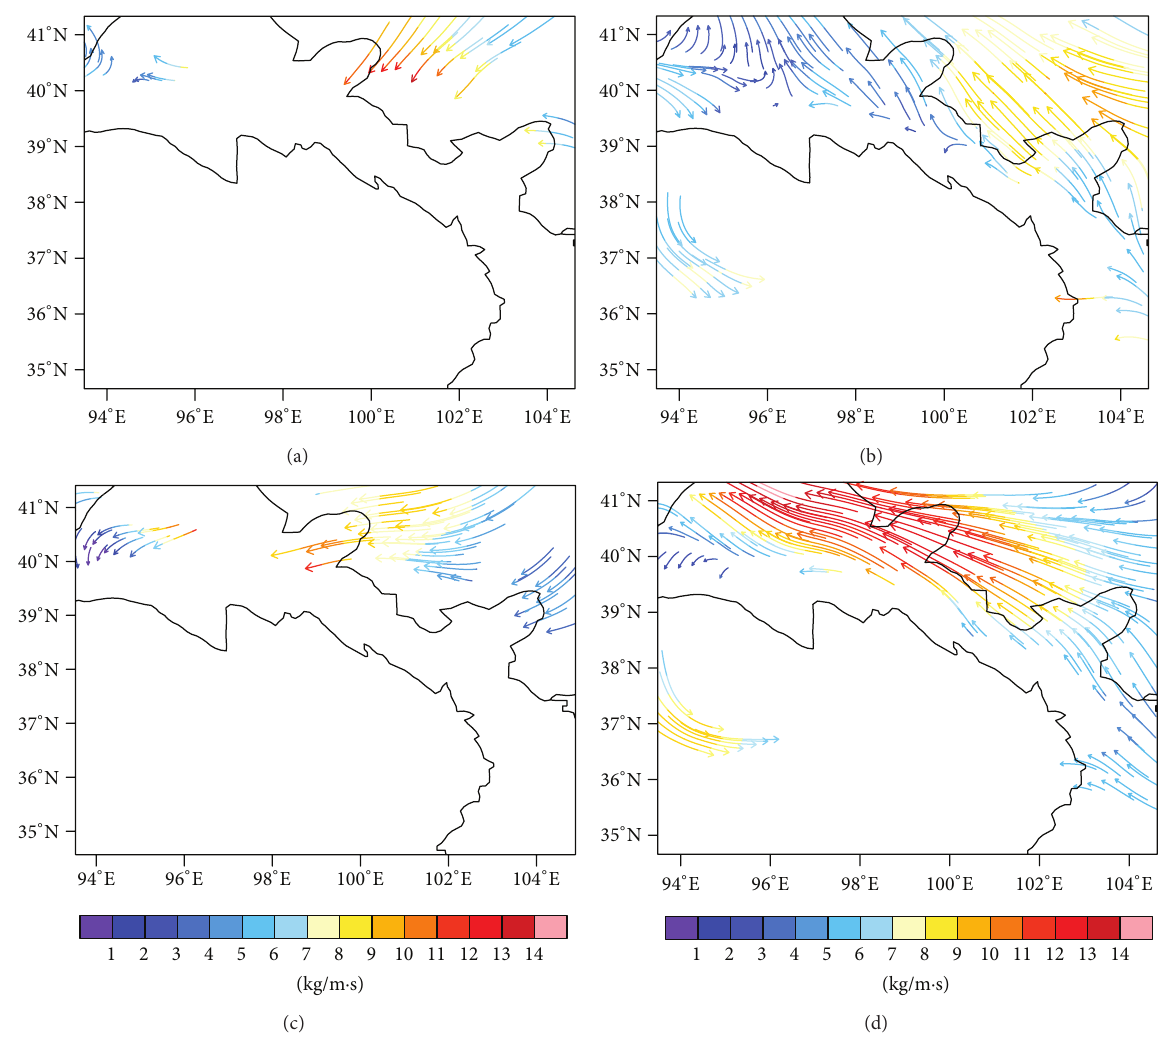
Figure 12: Moisture flux initial field for the CTRL and DA experiments: (a) CTRL; (b) DA-SAT; (c) DA-OBS; (d) DA-BOTH.